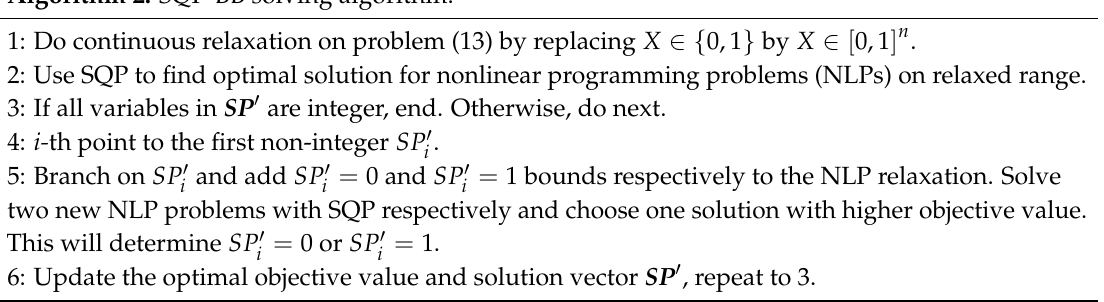
Algorithm 2. SQP-BB solving